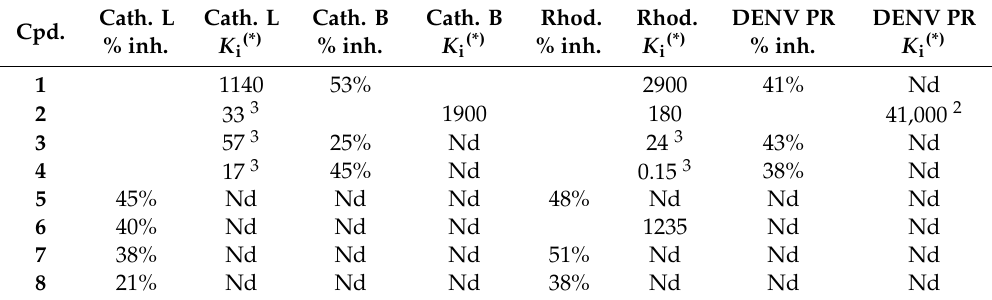
Table 1. Inhibition data for 1,4-naphthoquinone (NQ)-derived inhibitors of the general structure NQ-NH- L -Phe- L -Leu-OR, % inhibition at 20 µM or K i(*) (nM) 1 . Cpd.